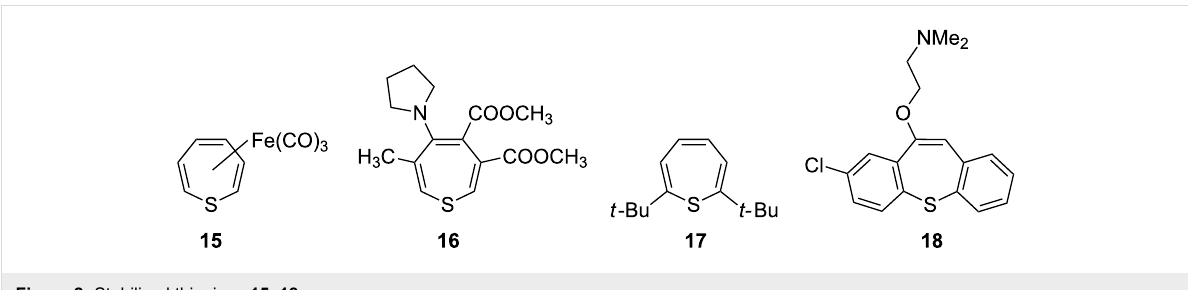
Figure 2: Stabilized thiepines 15 – 18